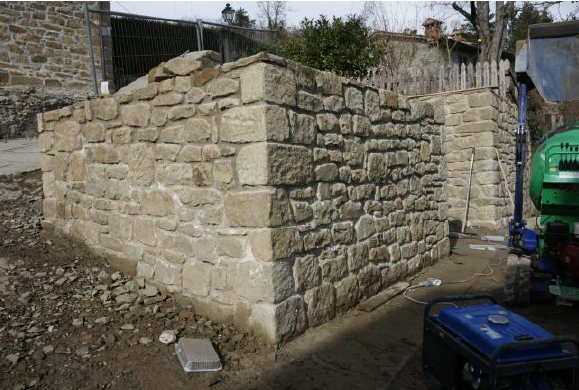
Figure 9. The new building under